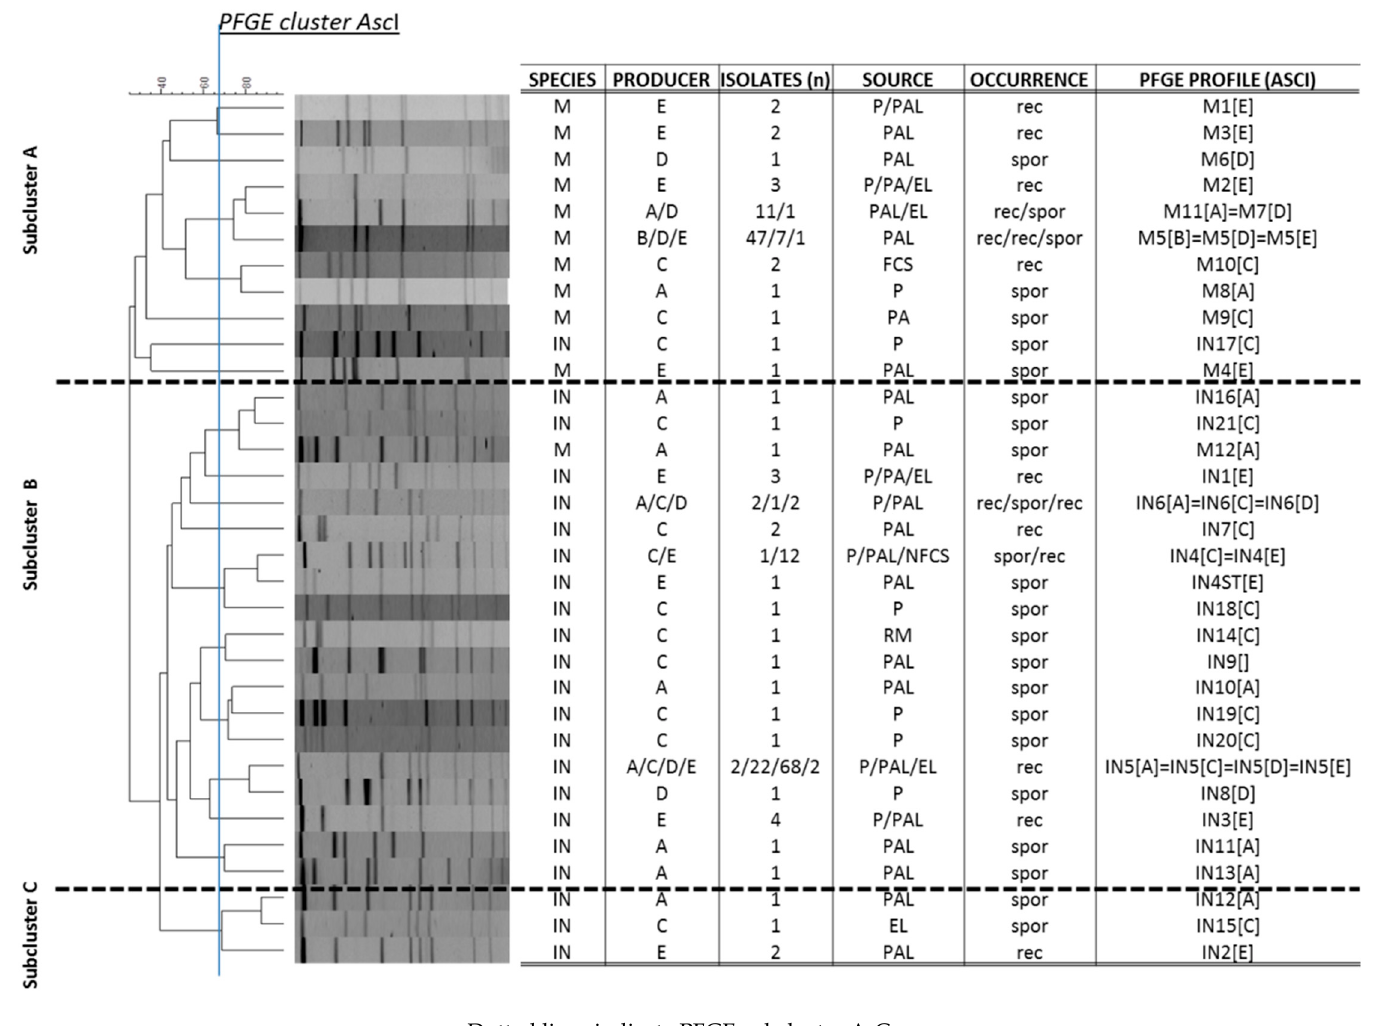
Figure 1. PFGE cluster analysis ( Asc I) of L. innocua (n = 139) and L. monocytogenes (n = 81) isolates included in this study.